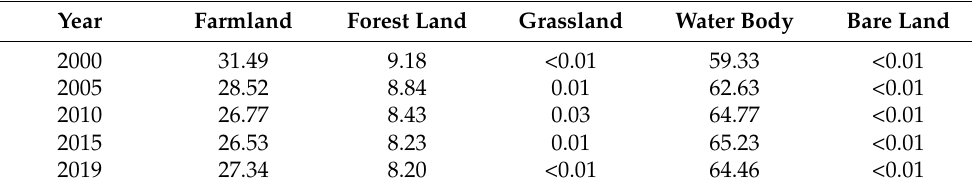
Figure 6. Spatial clustering characteristics of ESVs in SCBJ from 2000 to 2019. Table 4. Different land use contribution rates (%) in